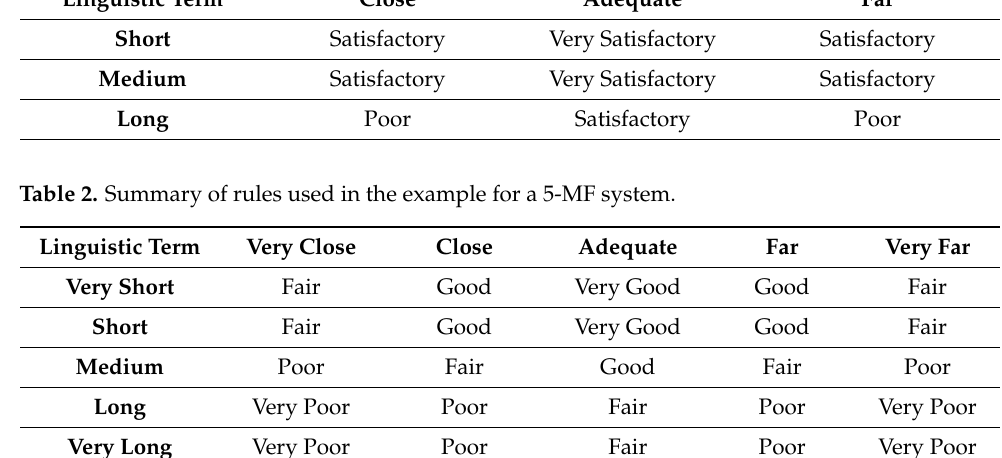
Table 1. Summary of rules used for a 3-MF system. Linguistic Term